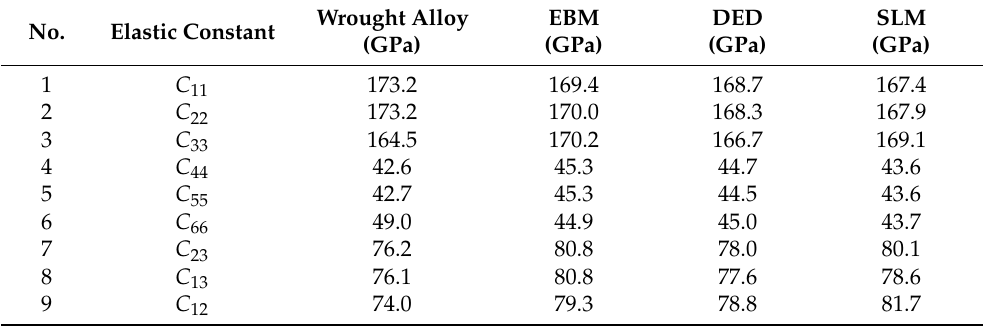
Table 4. The elastic constants, C ij , of the commercial wrought Ti6Al4V alloy sample and the three AM Ti6Al4V samples ( n = 6). The maximum error (calculated based on the standard deviation and instrumental error) in the longitudinal elastic constants C ii (i = 1,2,3) is 0.33 GPa, the maximum error in the shear elastic constants C jj (j = 4,5,6) is 0.28 GPa, the maximum error in the shear elastic constants C 23 , C 13 , and C 12 is 0.42 GPa.